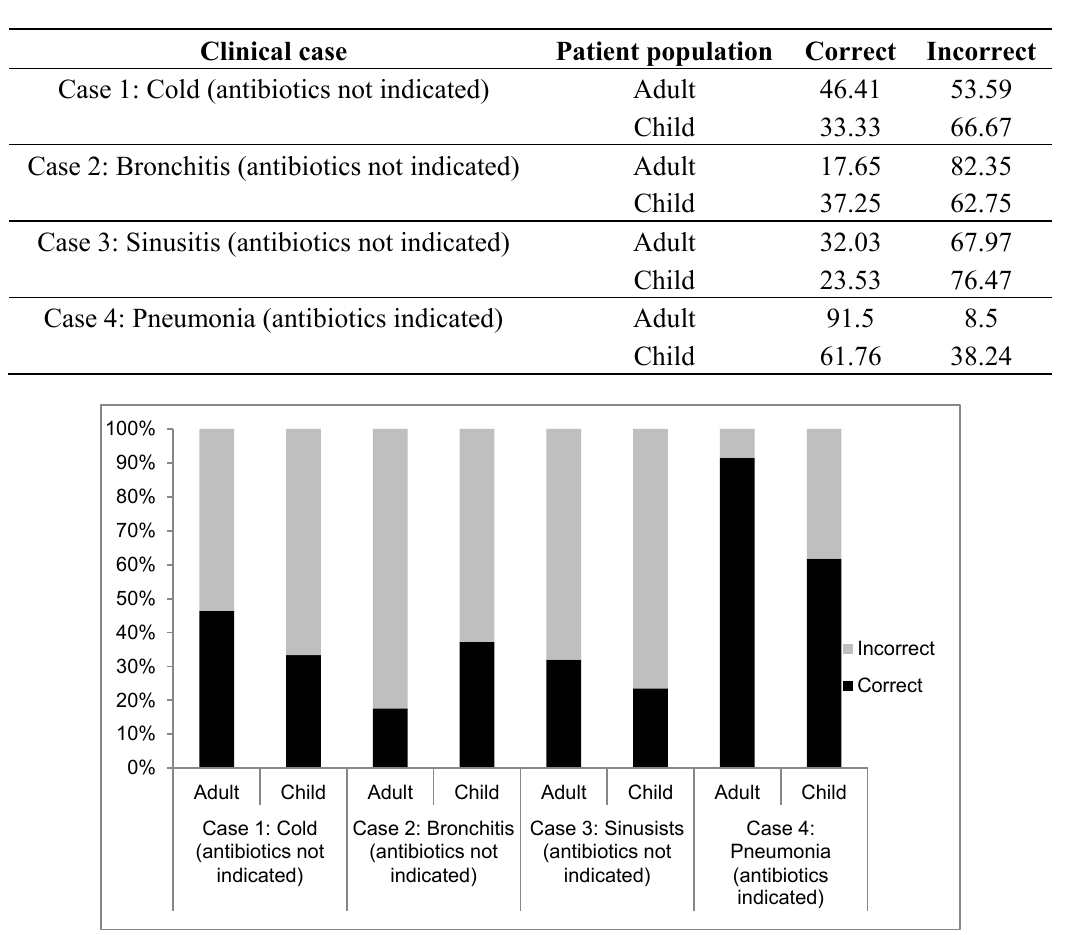
Figure 1. Physician treatment choices in response to acute respiratory infection (ARI) clinical